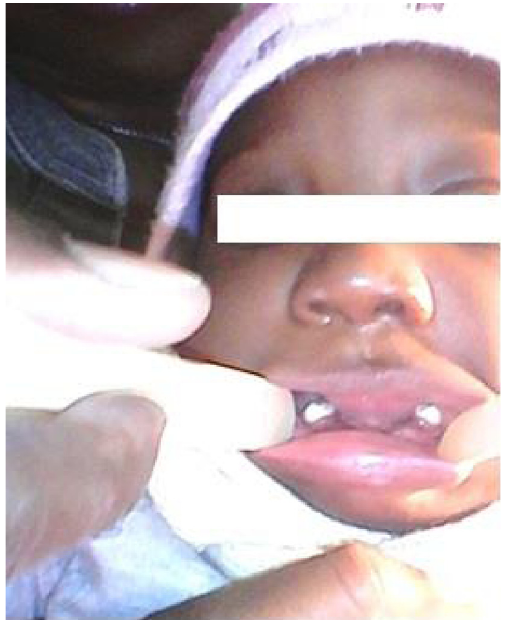
Fig. 7. Edentulous mandibular incisor region and